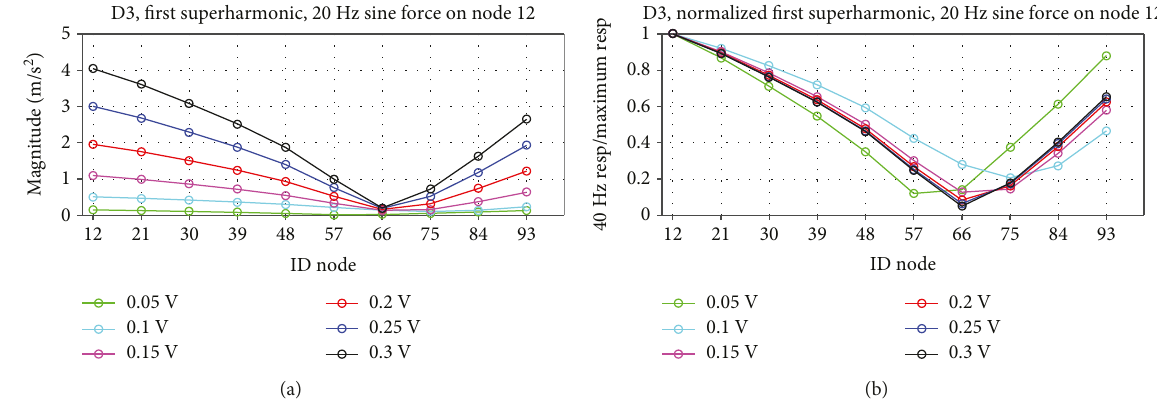
Figure 49: 40 Hz FFT magnitudes, 20Hz sine excitation force applied to node 12, D3 scenario.